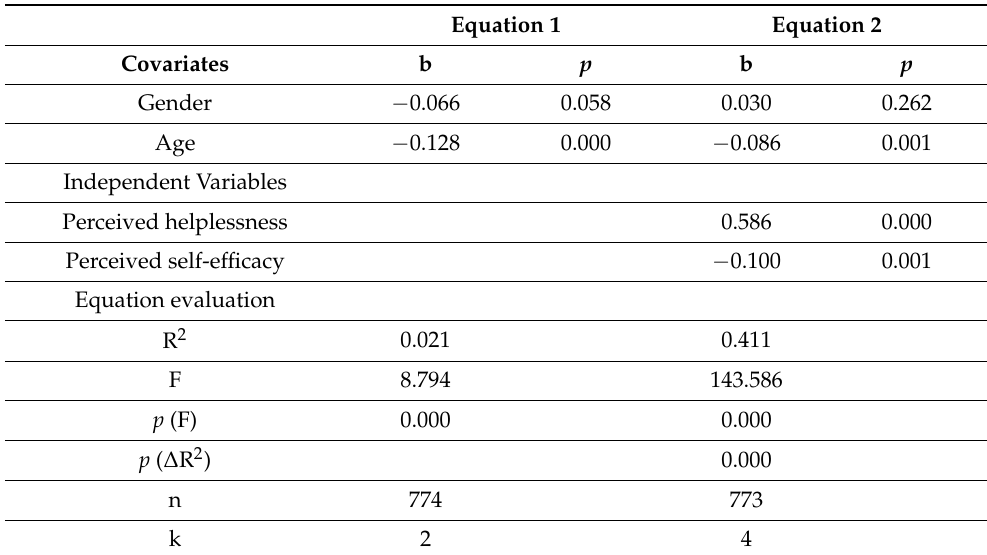
Table 6. Findings of the regression analysis for mental and physical exhaustion.